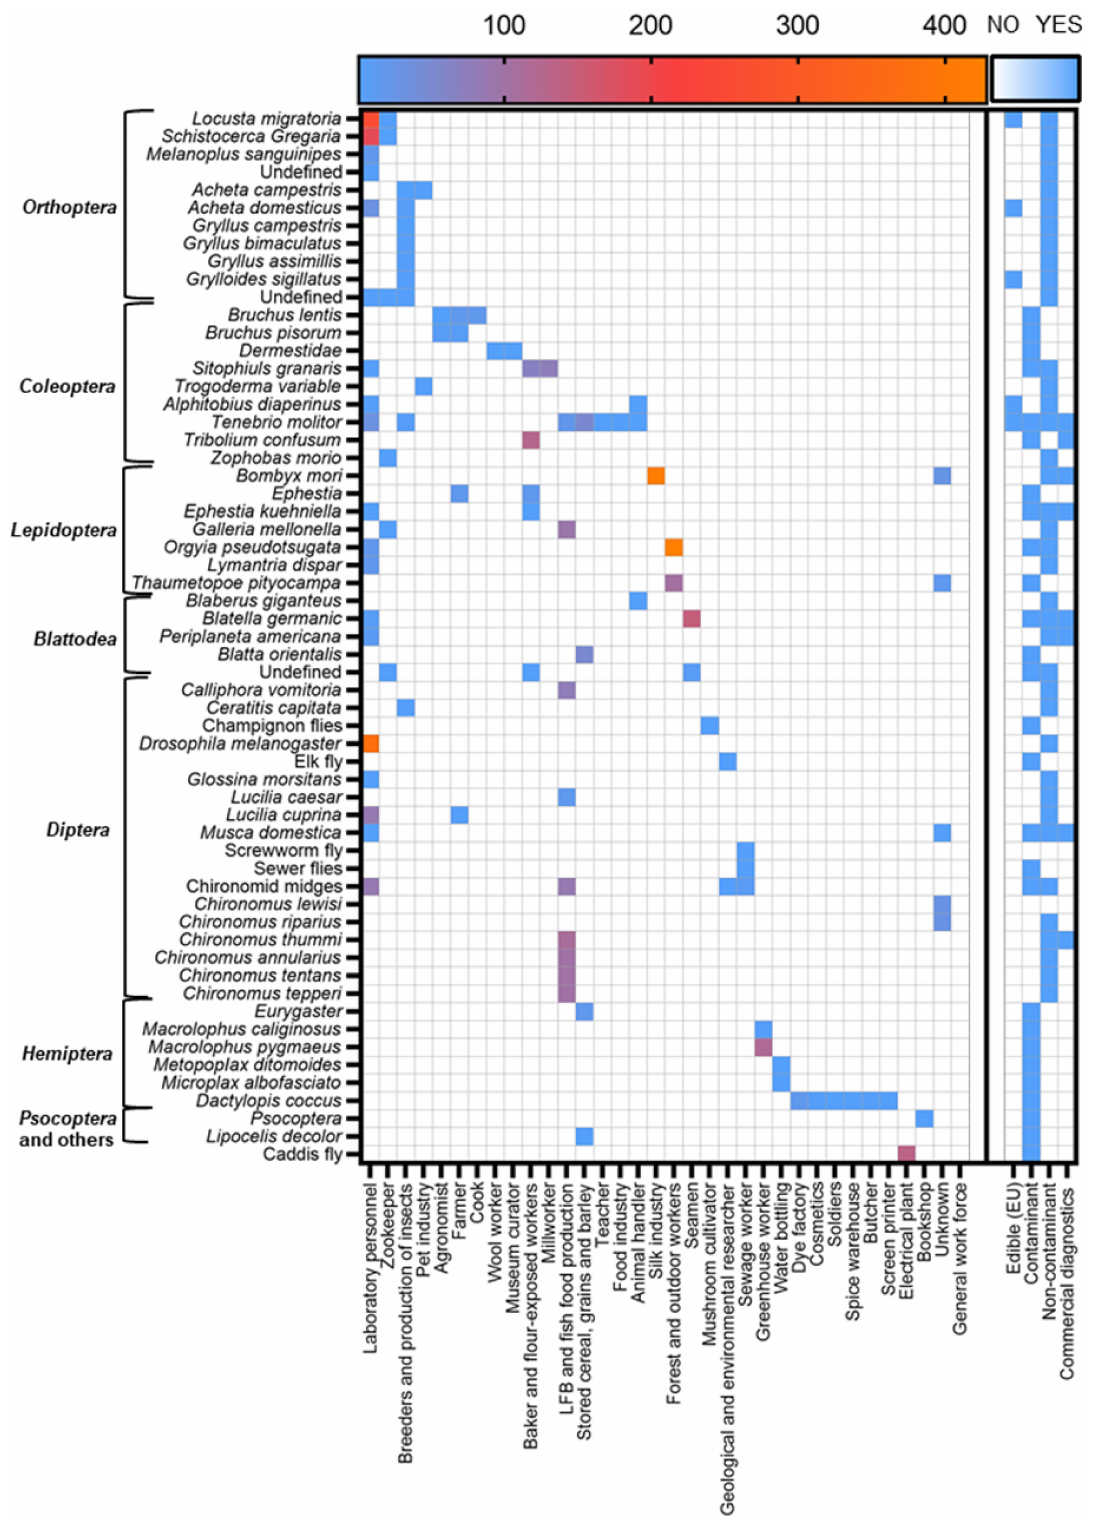
Figure 3. Number of cases assessed for all insect species and affected occupations. Number of cases based on the assessed cases of each publication. Edible (EU): based on current approval or applications being assessed. Exposure by insects as the contaminant vs. non-contaminant. Commercial diagnostics: either sIgE or SPT extract commercially available. Hymenoptera were excluded based on the large number of reports and currently available